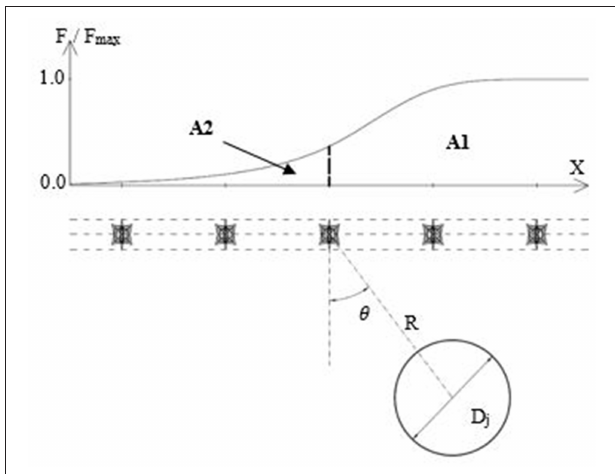
FIGURE 1 | Oblique load case illustration with downburst loading force distribution along